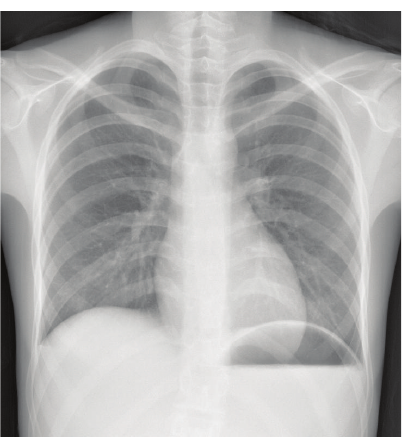
Figure 1: Erect chest radiograph demonstrating gastric air-fluid level.